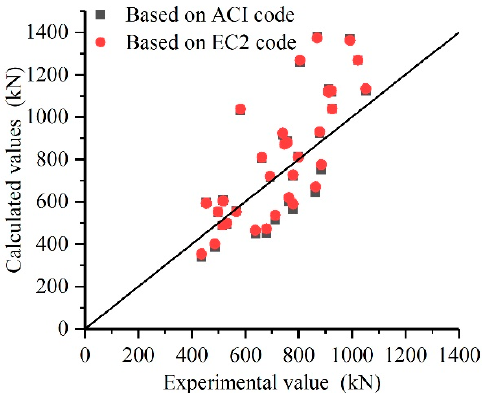
Figure 10. Comparison of the calculated and experimental values based on the ACI code and EC2 code. EC2